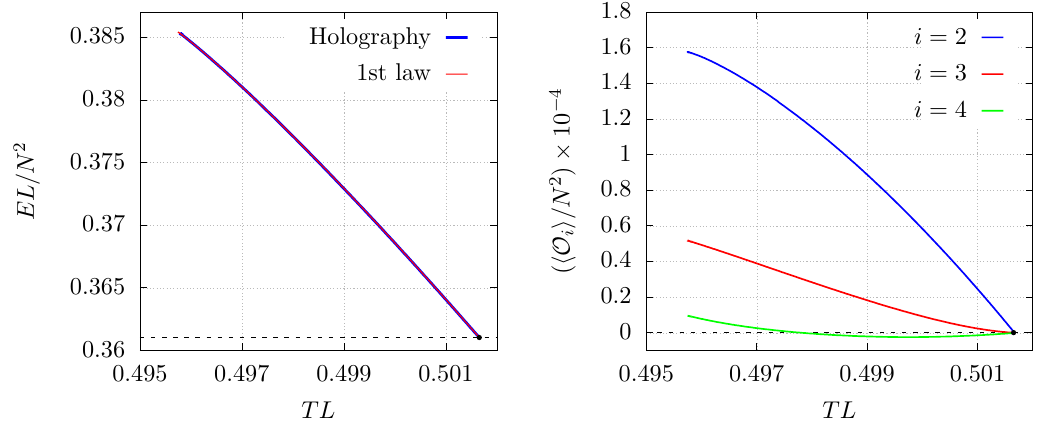
Figure 8. Left: energy comparison for the ‘ = 1 lumpy black hole family when computed by integrating the 1st law of thermodynamics (red line), and when computed using holography (4.4) (blue line). Right: dimensionless vev of the dual lower-dimensional scalar field operators S 2 , 3 , 4 as a function of the dimensionless temperature.